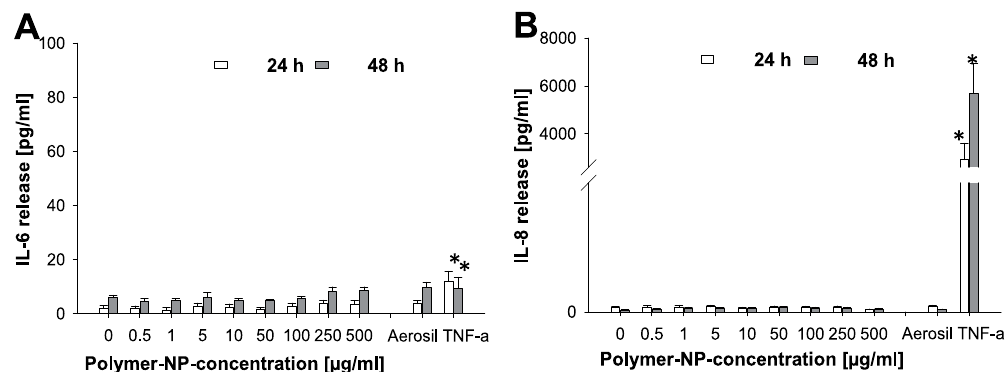
Figure 5. Release of IL-6 ( A ) and IL-8 ( B ) after treatment of HepG2 cells with increasing concentrations of polymer-NPs after 24 and 48 h. 250 μ g/mL Aerosil 200-NPs und 20 ng/mL TNF α were used as controls. N = 3, technical duplicates, means and standard deviation ( * p < 0.05; ** p < 0.01 in comparison to untreated